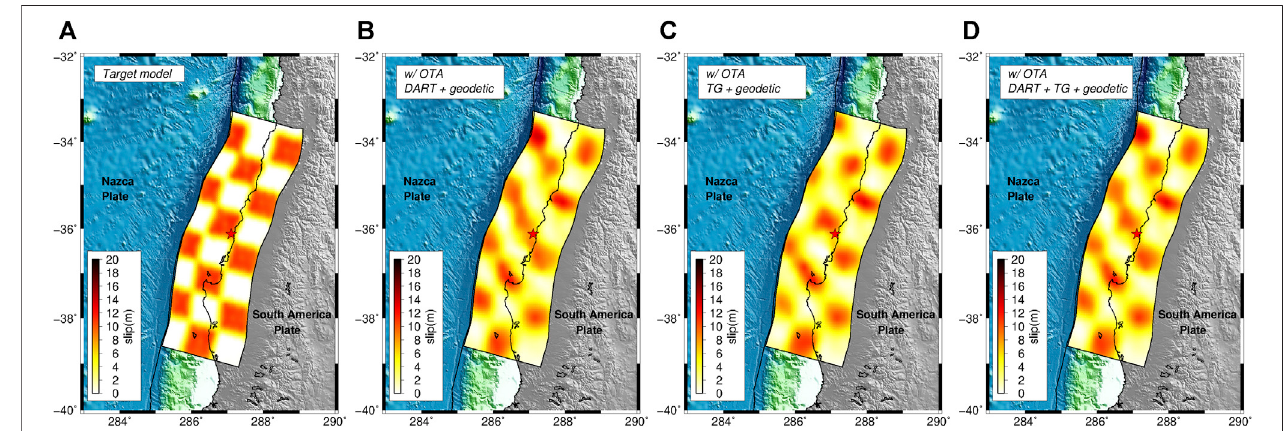
FIGURE 3 | Target slip model (A) ; slip models estimated by jointly inverting geodetic and DART data (B) , geodetic and tide-gauge data (C) , geodetic, DART, and tide-gauge data (D) . All of the inversions have been performed using OTA.